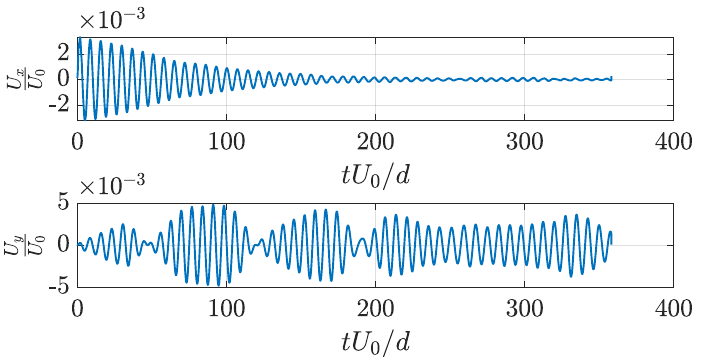
Figure 10. Time record of the velocity of vibration or the edge of the cylinder: velocity component in the direction of motion ( top panel); velocity component in the transversal direction ( bottom panel).